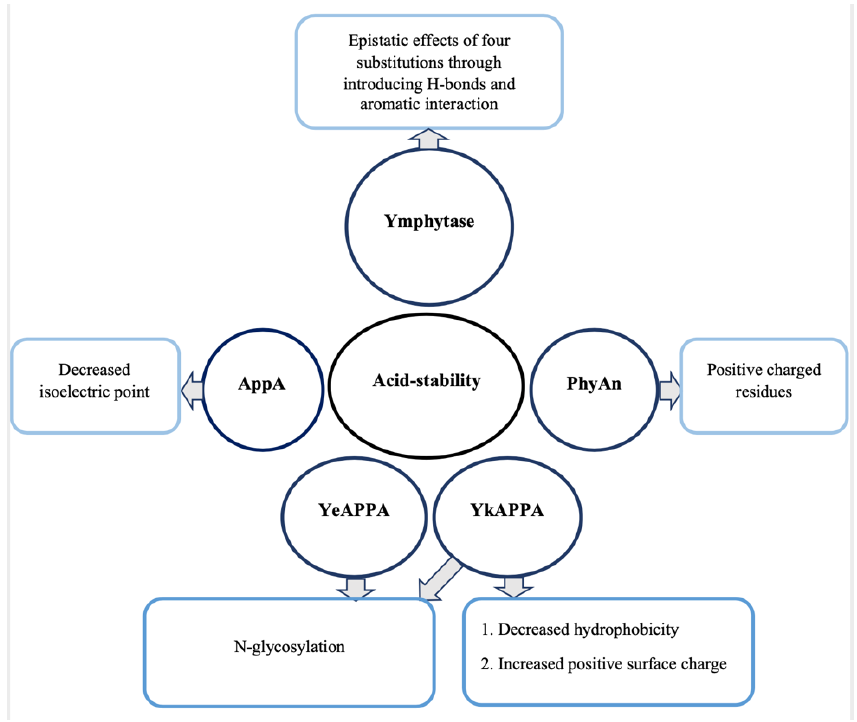
Figure 8. Contributing factors in acid stability of Ymphytase, PhyAn, YkAPPA, YeAPPA and AppA phytases.